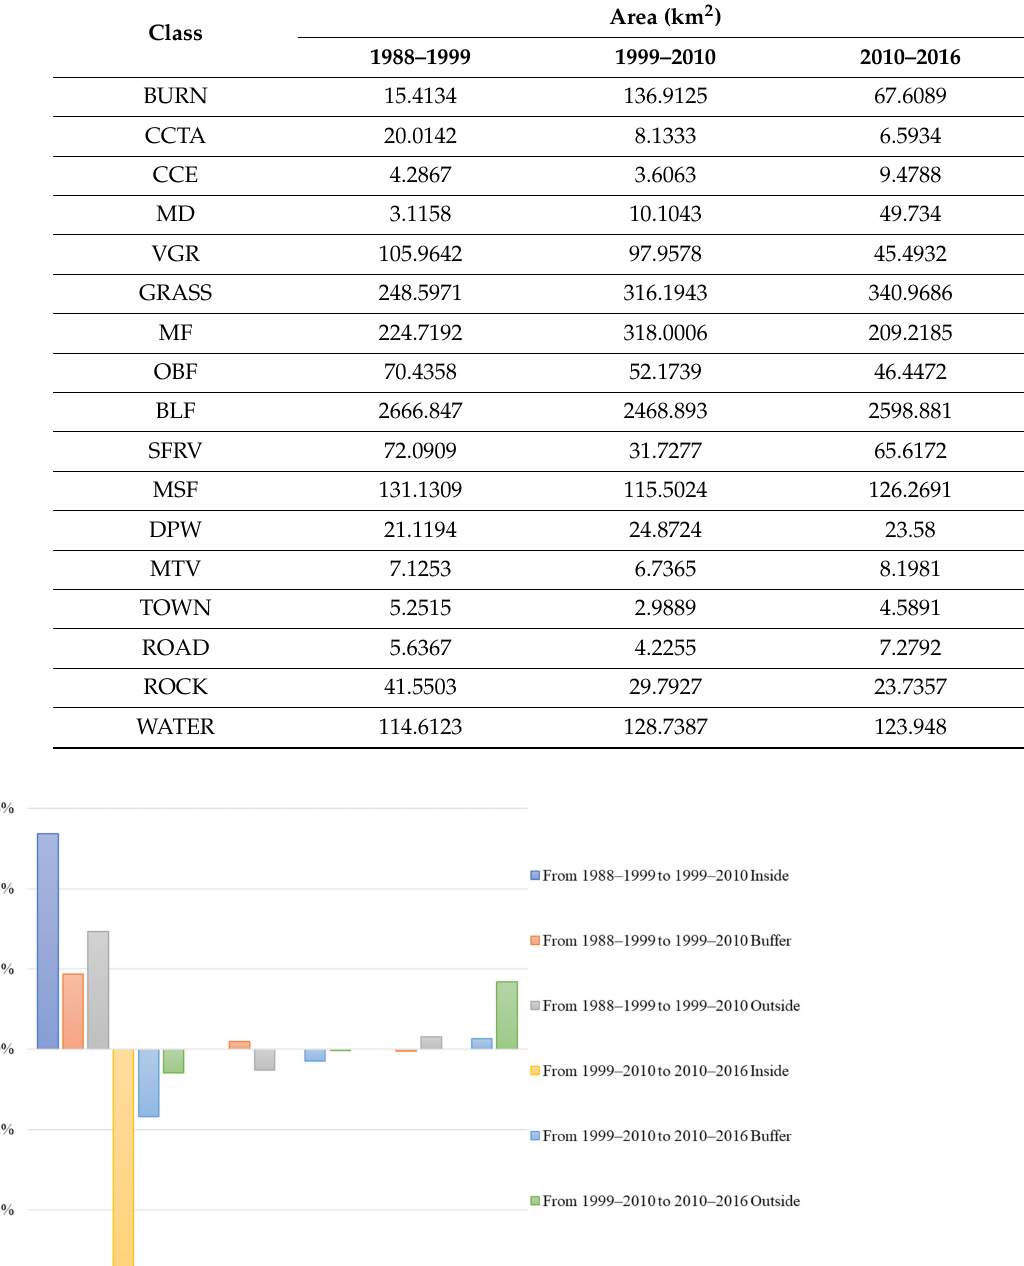
Table 4. Area (km 2 ) of class covers in first (1988–1999), second (1999–2010), and third (2010–2016) periods. BURN = burned area, CCTA = clearcutting for timber or agricultural, CCE = clearcutting for electricity lines, MD = mixed disturbance, VGR = vegetation recovery, GRASS = grassland, MF = mixed forests, OBF = oak–Daurian birch forests, BLF = birch and larch forests, SFRV = spruce forests in a river valley, MSF = mountain spruce forests, DPW = dwarf pine woodland, MTV = mountain tundra vegetation, TOWN = settlement, ROAD = unpaved road, ROCK = stream bedrocks, and WATER = water.